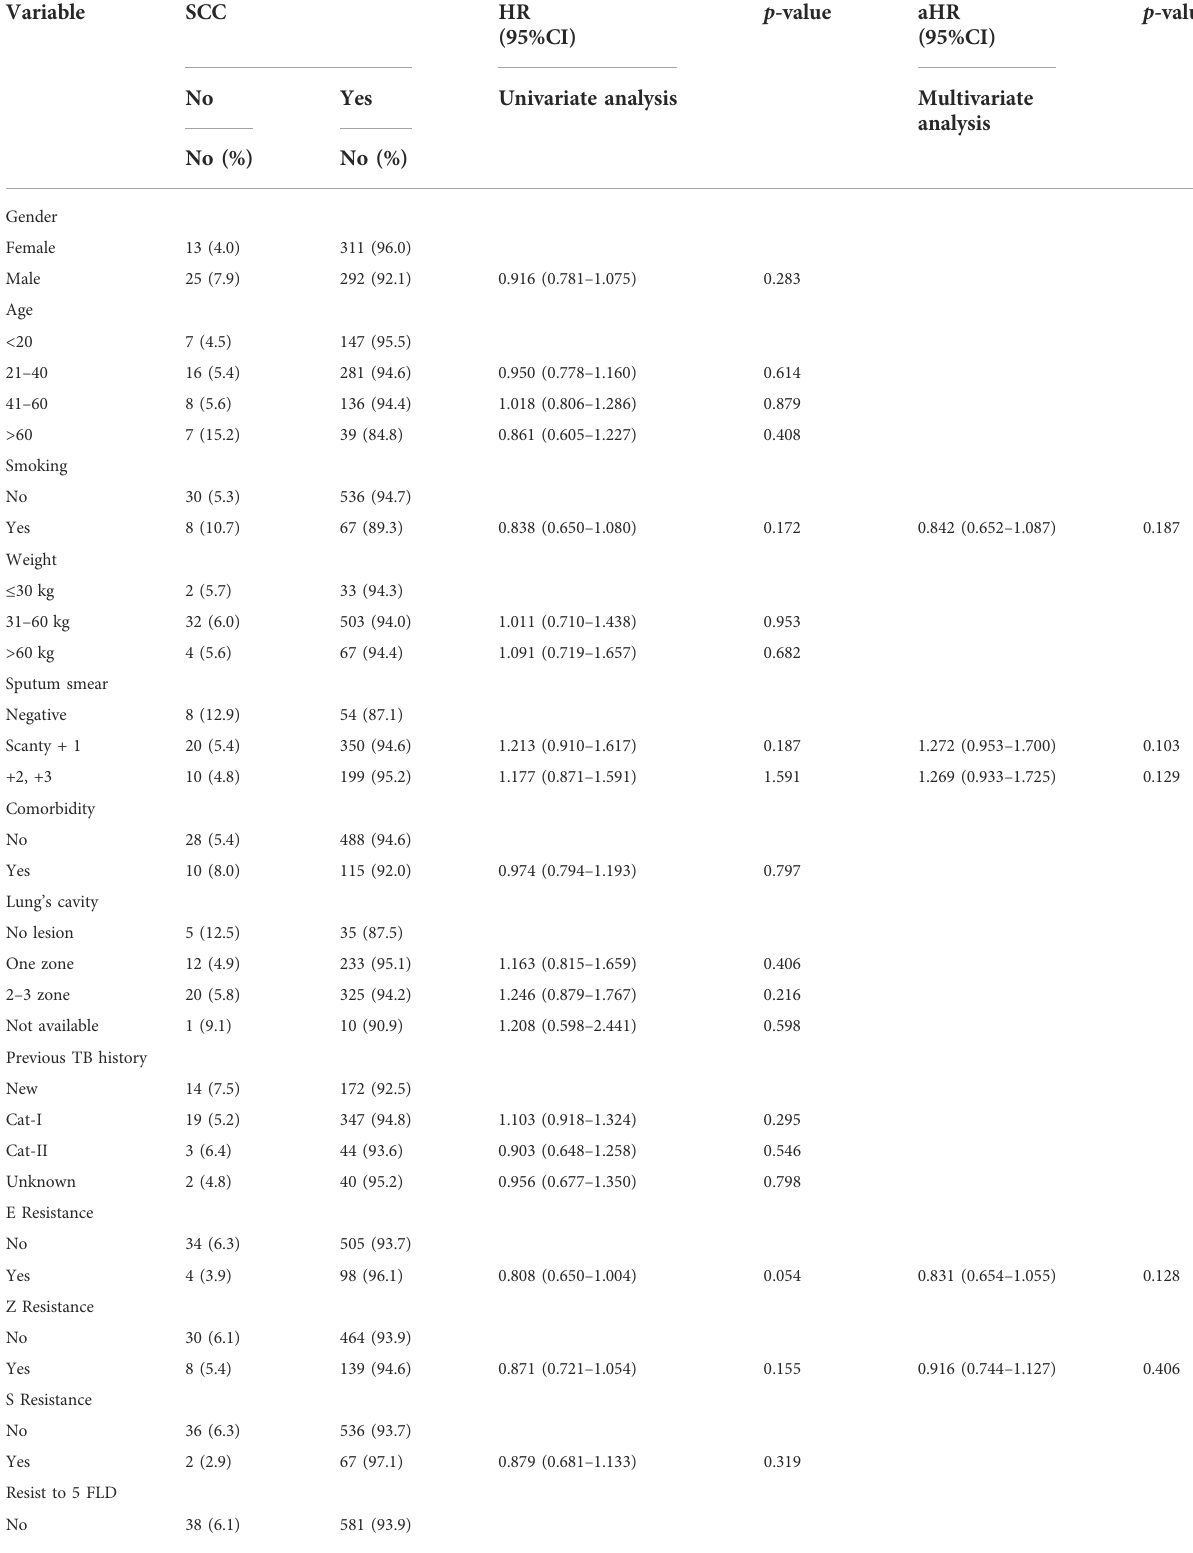
TABLE 2 Predictors of time to sputum culture conversion in MDR-TB patients N = 641.